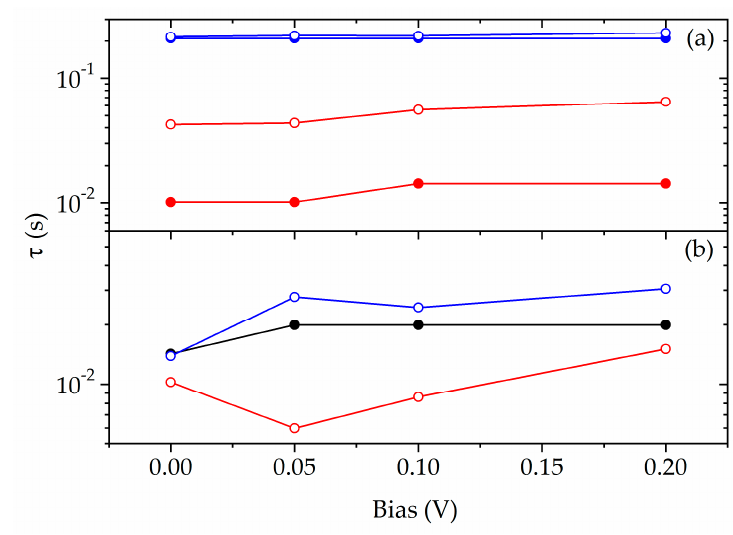
Figure 5. Relaxation times vs. bias of low (blue points) and medium-frequency (red points) contributions, as calculated by distribution of relaxation times (DRT) (full symbols) and equivalent circuits (open symbols) at 600 ( a ) and 700 °C ( b ).